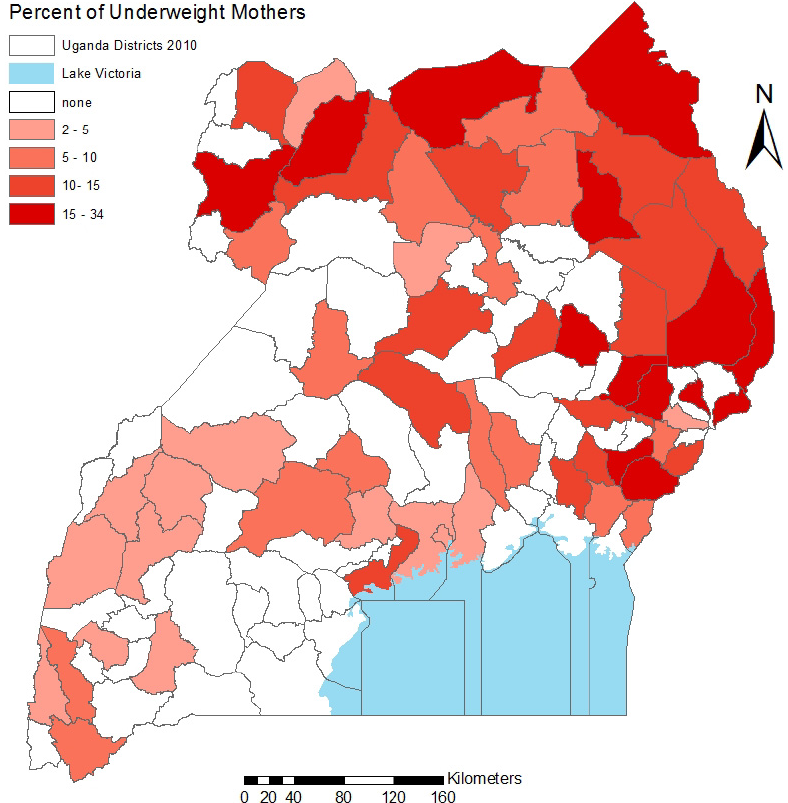
Figure 2. The percentage of underweight mothers in Uganda as quintiles, by district, where darker districts experience higher levels of